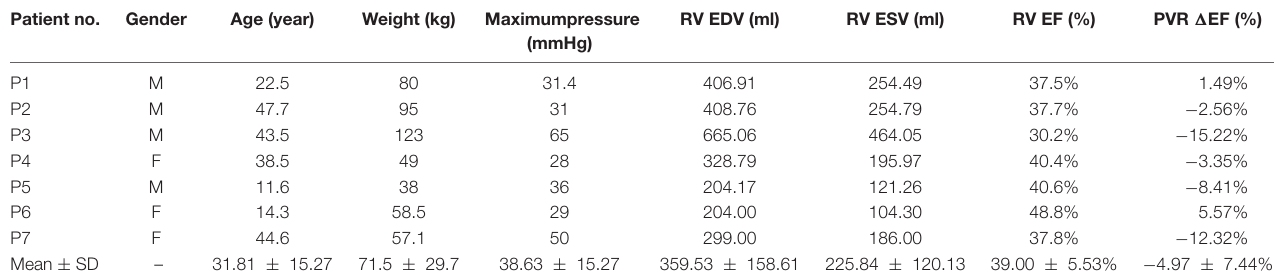
TABLE 1 | Patient demographic and CMR data. Patient